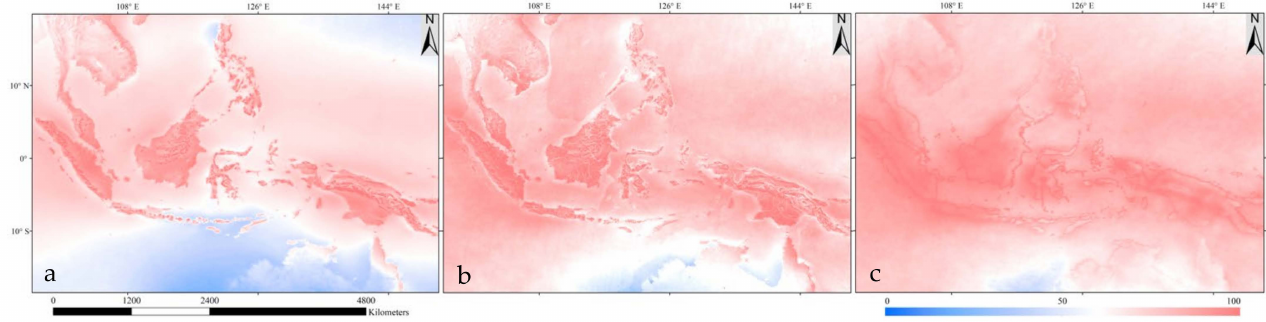
Figure 21. Average cloud frequency (%) in the Southeast Asian Archipelago areas for the GLHCC ( a ), MOD/MYD35 ( b ), and PATMOS-X ( c ) in